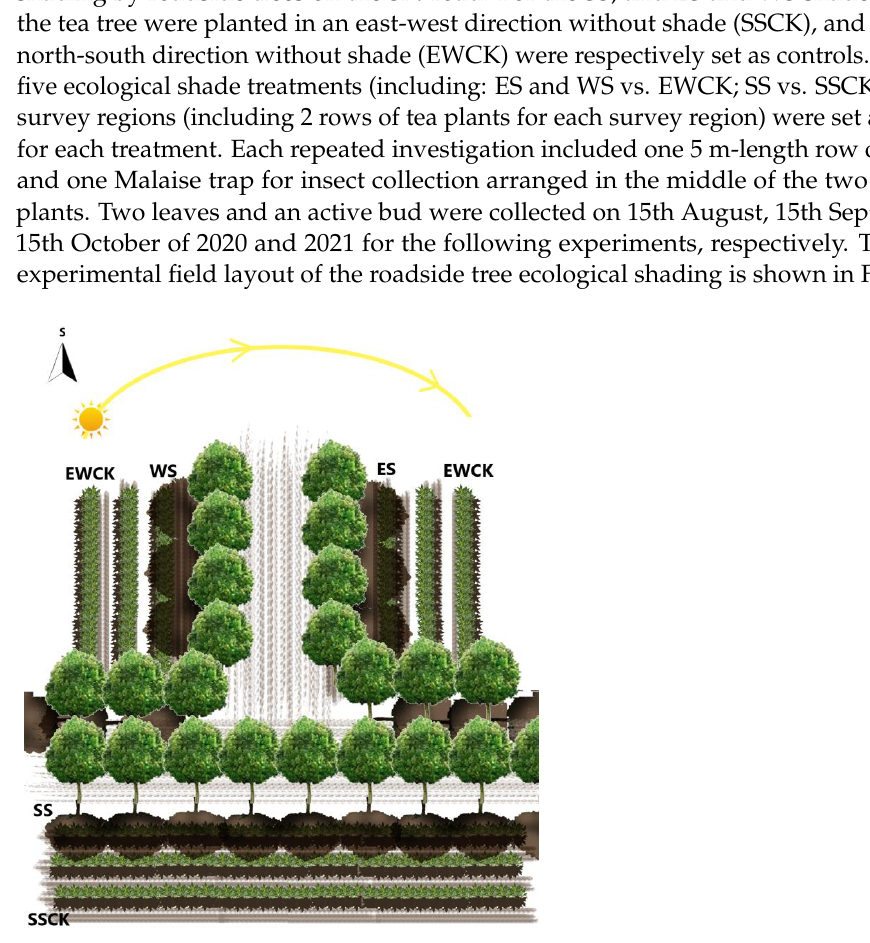
Figure 1. Experimental plot layout of roadside tree ecological shading (i.e., camphor trees) in the tea plantation (Note: ES — east shading; WS — west shading; EWCK — control of the shading treatments of WS and ES; SS — south shading; SSCK — control of the shading treatment of SS. The same in the following figures and tables).